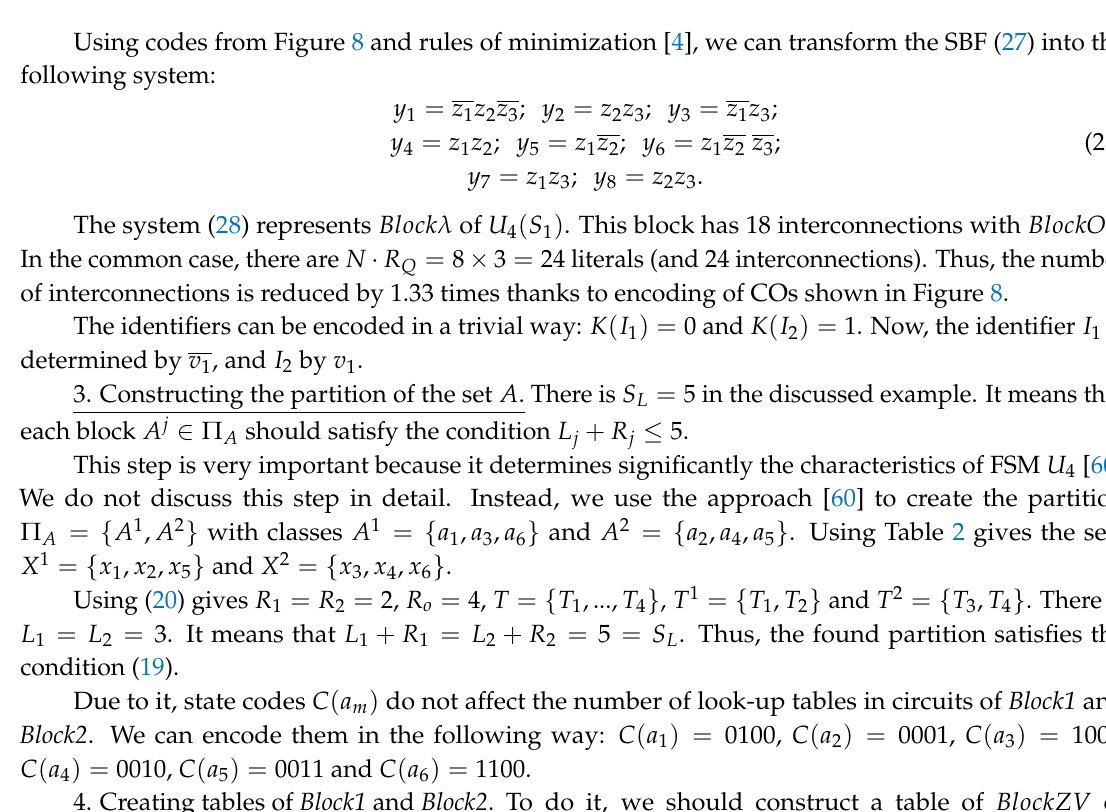
Figure 8. Outcome of encoding of collections of outputs